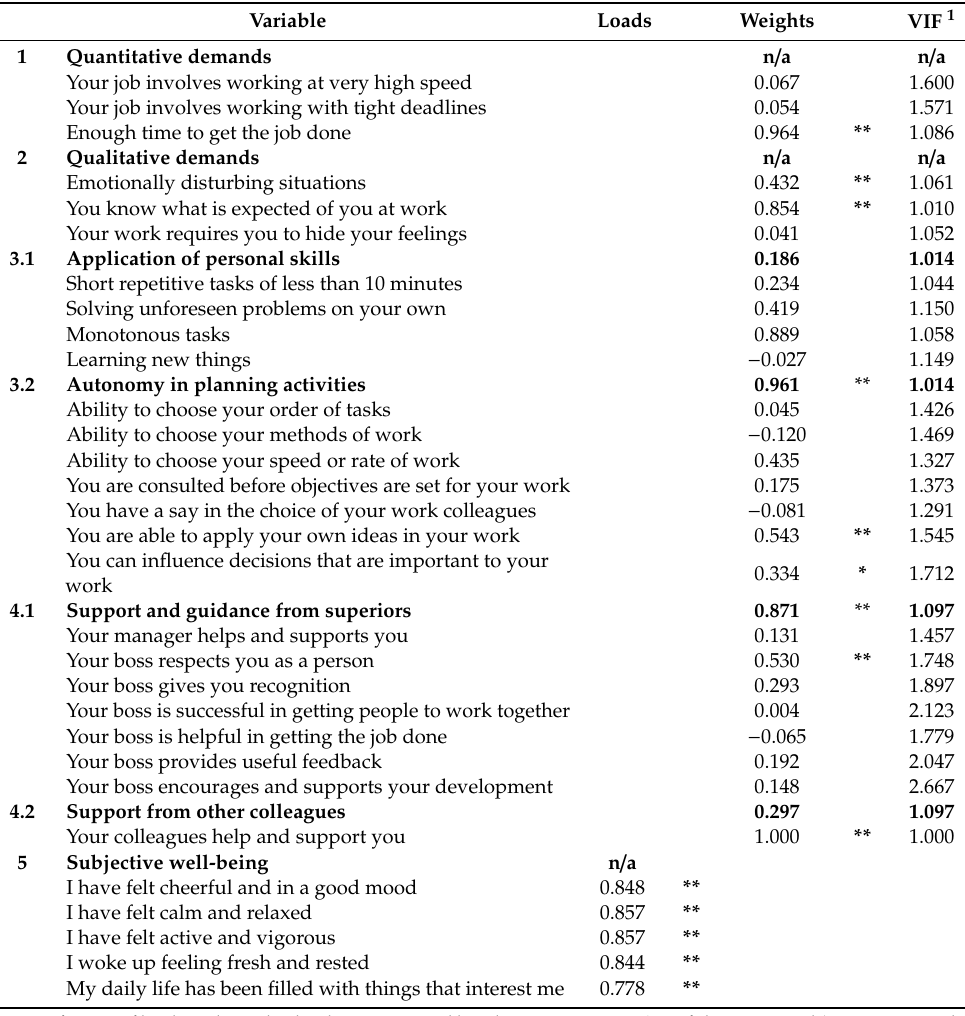
Table 1. Mediation model of